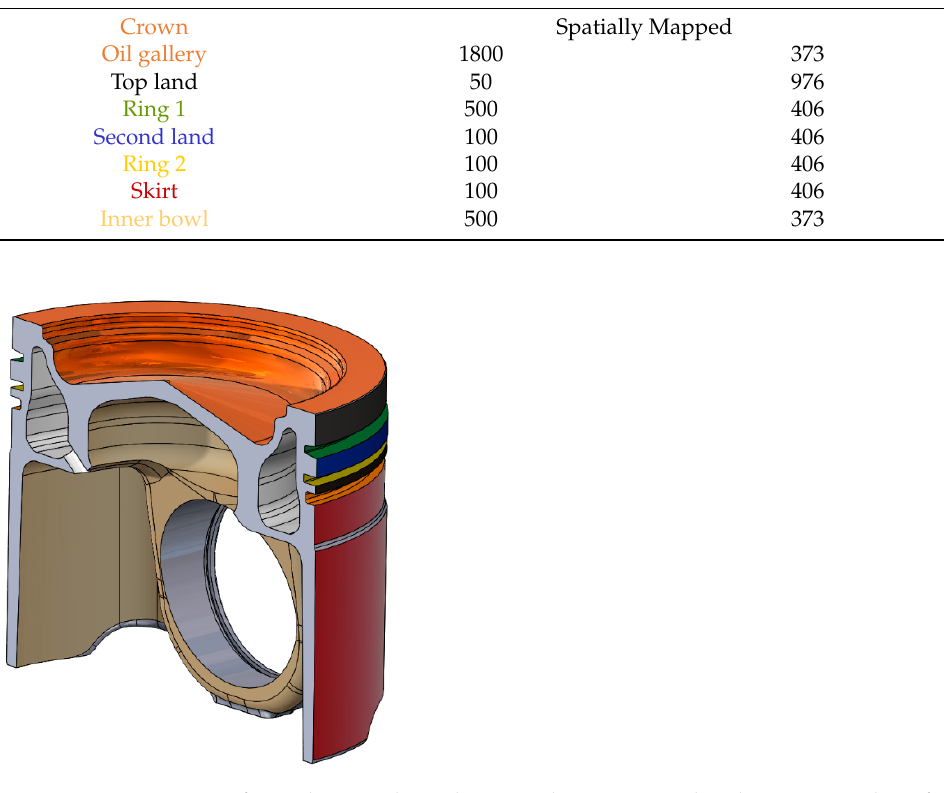
Figure 3. Locations of steady-state boundary conditions: initial values were taken from Gonera et al. [24], then modified to match experimental temperature plug measurement data.